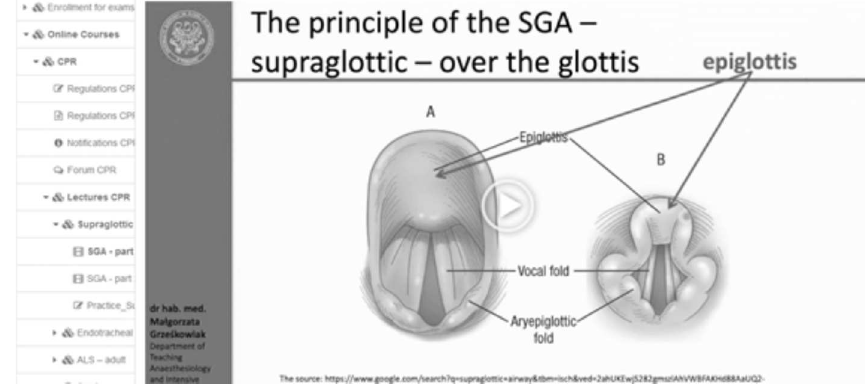
Figure 7. The use of pictures/figures in an e-learning presentation to demon- strate the principle of supraglottic airway – SGA